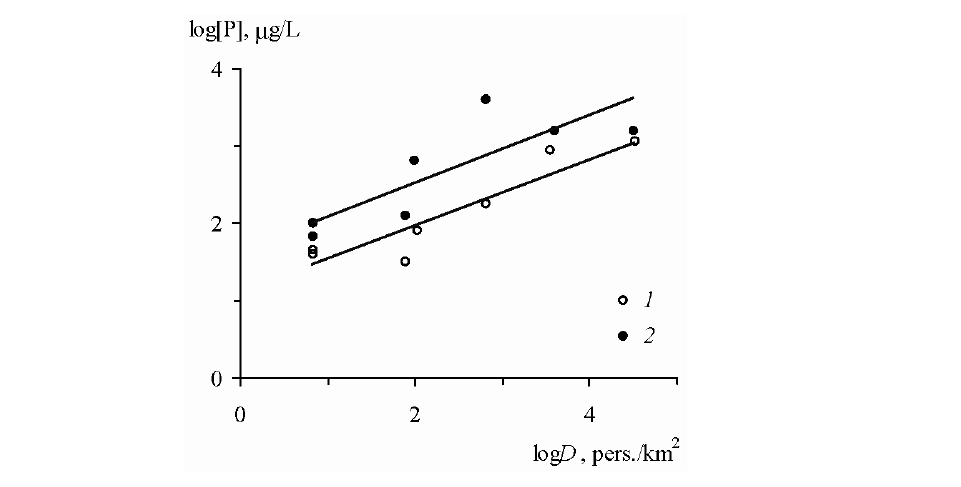
Figure 4. Relationship between the average annual concentrations of dissolved forms of mineral ( 1 ) and total ( 2 ) phosphorus in the waters of the primary hydrographic network and the population density D [6].